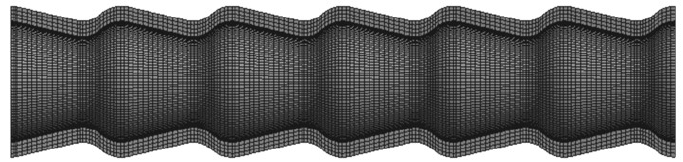
Figure 5. Mesh model of the conically corrugated tube.